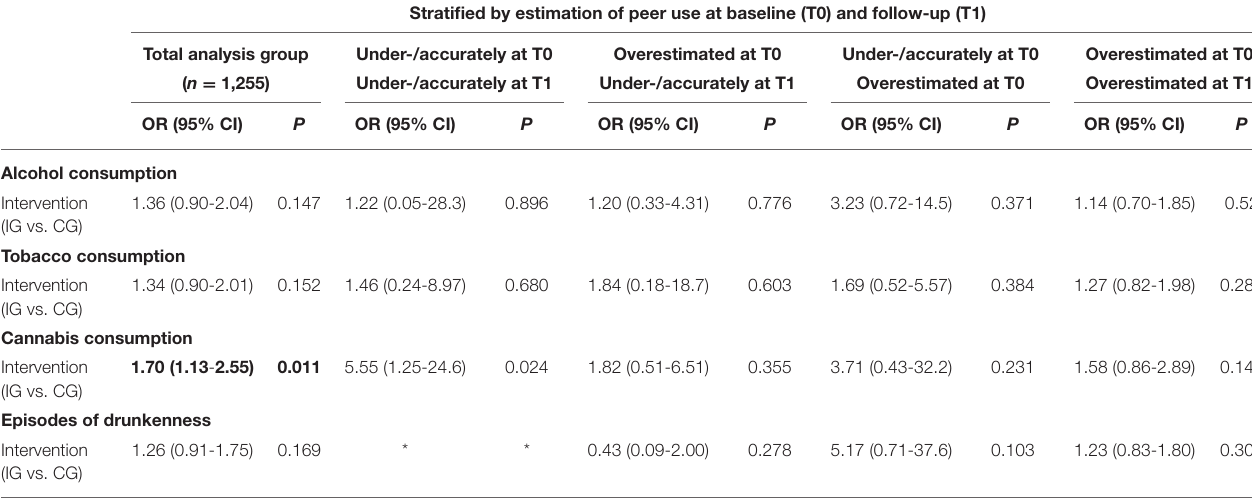
TABLE 5 | Results of multivariable logistic regression models (total and stratified); Outcome: consumption not increased 5 months post-intervention. Stratified by estimation of peer use at baseline (T0) and follow-up (T1) Total analysis group Under-/accurately at T0 Overestimated at T0 Under-/accurately at T0 Overestimated at T0 Under-/accurately at T1 Under-/accurately at T1 Overestimated at T0 Overestimated at T1